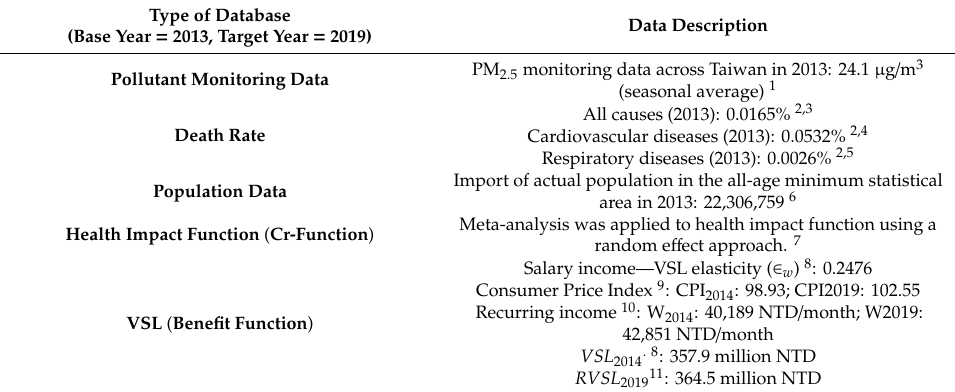
Table 2. Environmental benefit mapping and analysis program (BenMAP)